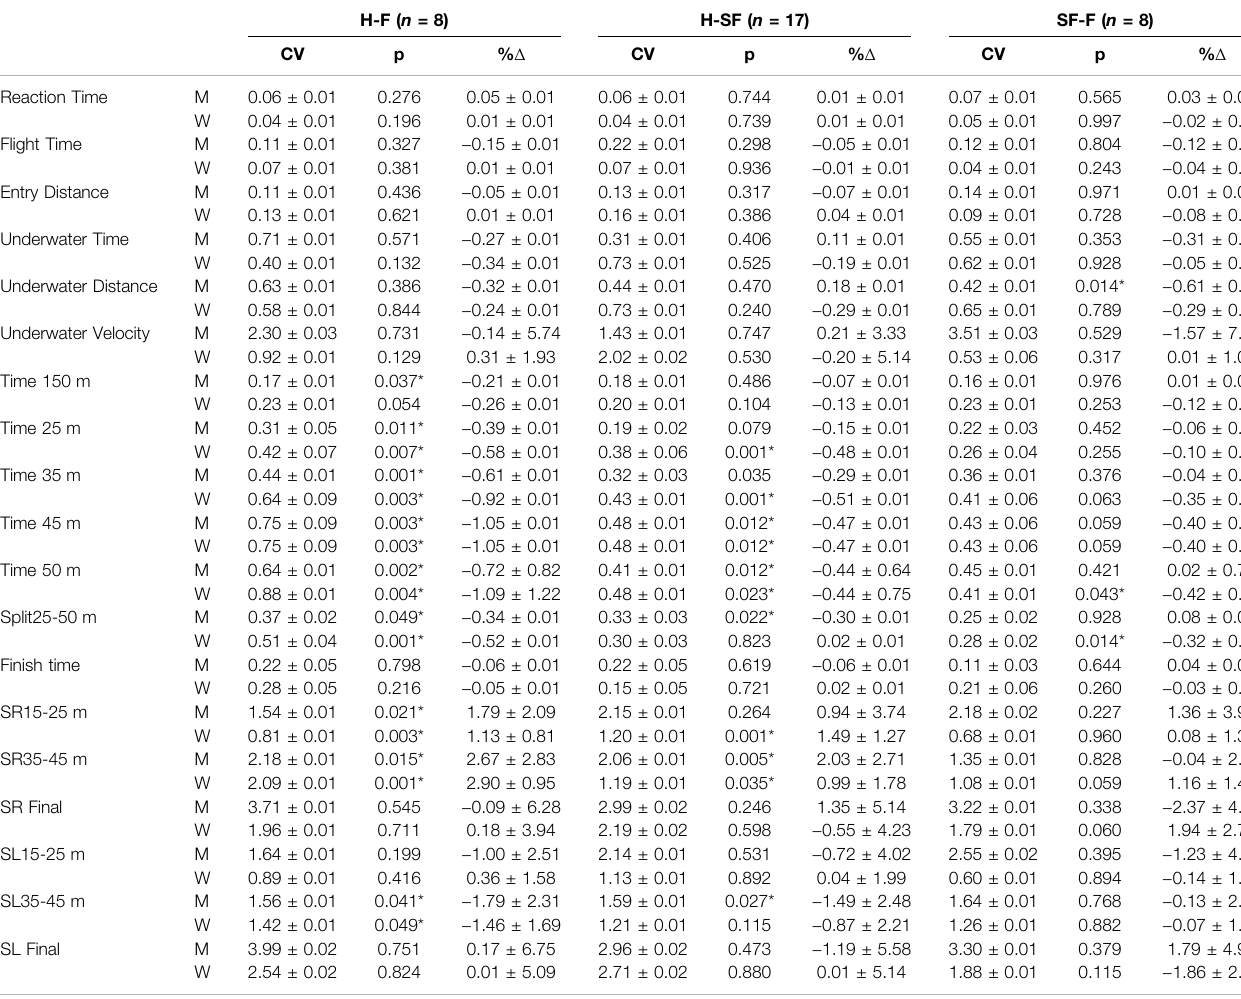
TABLE 8 | Butter fl y intra-athlete ’ s coef fi cient of variation (CV) and relative change in performance (% Δ ). Men (M); Women (W); Heat (H); Semi- fi nal (SF); Final (F) (LEN European Senior Championships 2021). H-F ( n =